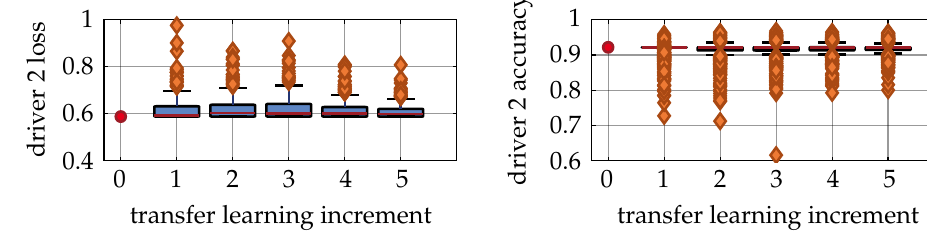
Figure 9. Training results for reference driver 2 (reference).